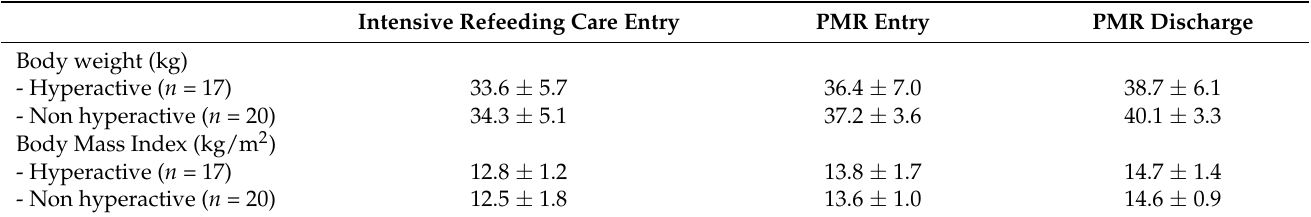
Table 5. Comparison between hyperactive and non-hyperactive patients concerning body weight and